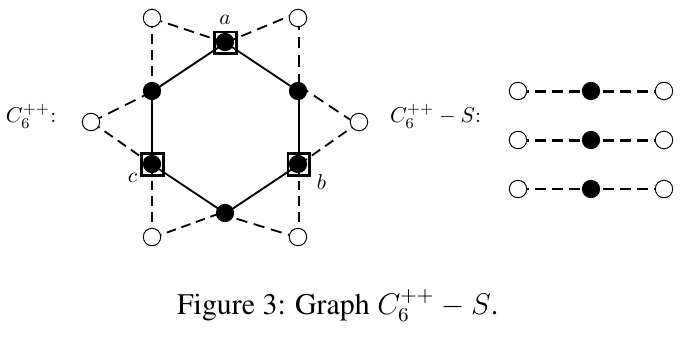
Figure 3: Graph C ++